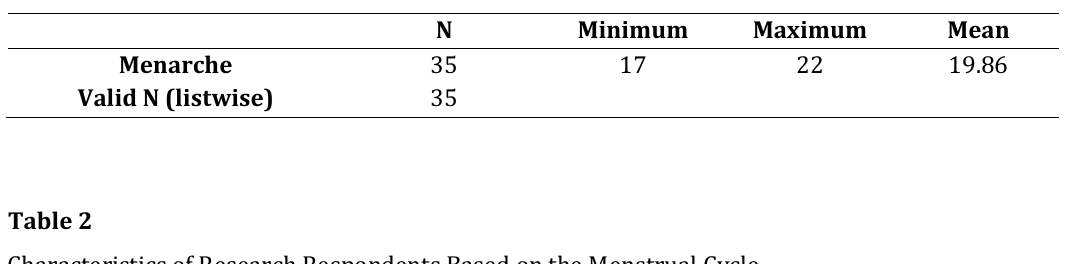
Characteristics of Research Respondents Based on the Menstrual Cycle